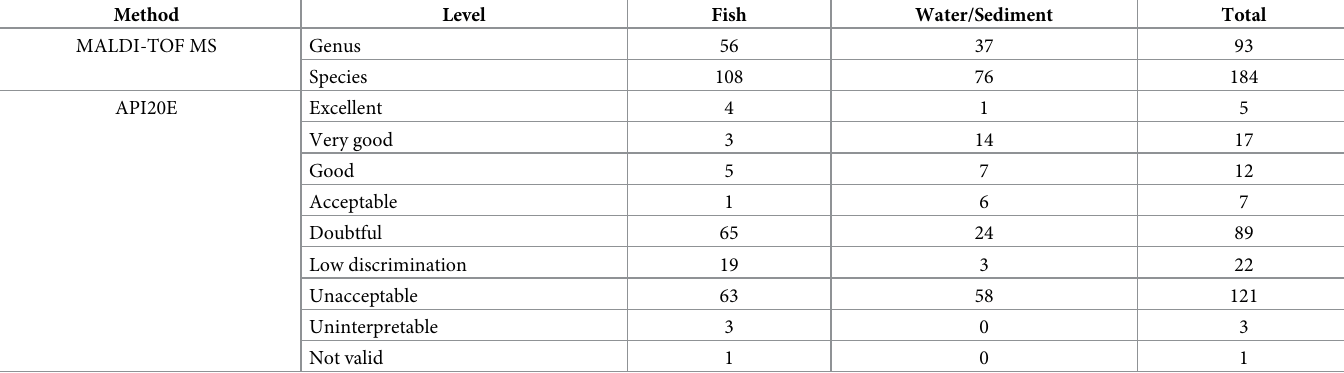
Table 1. Levels of reliability in results of bacterial identification between API20E and MALDI-TOF MS methods applied to 164 strains isolated from fish and 113 from water/sediment samples.